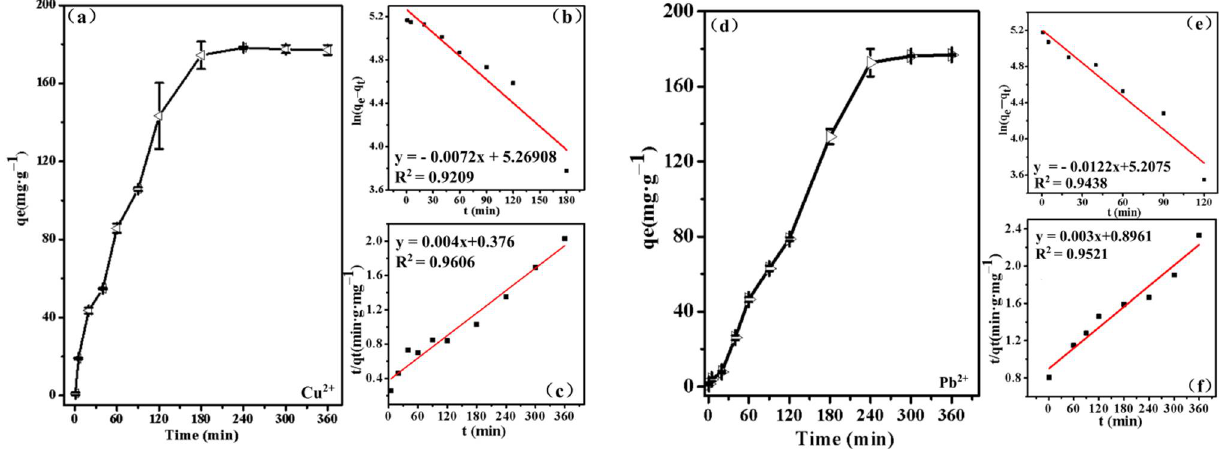
Figure 11. The effect of contact time on the adsorption of Cu(II) ions by TA ( a ); pseudo-fist-order model ( b ) and pseudo-second-order model ( c ); the effect of contact time on the adsorption of Pb(II) ions by TA ( d ); pseudo-fist-order model ( e ) and pseudo-second-order model ( f ). Compared with other adsorbents, the biggest advantage of TA as adsorbent is lower costs, as shown in Table 4, several solid waste based low cost adsorbents have been used for the removal of Cu(II) and Pb(II) in previous studies. In general, the removal capacity of TA adsorbent for Cu(II) and Pb(II) compares favorably with those of other solid waste based adsorbents under single metal ions batch conditions. Table 4. Comparison of adsorption capacity of Cu(II) and Pb(II) by TA and other adsorbents.